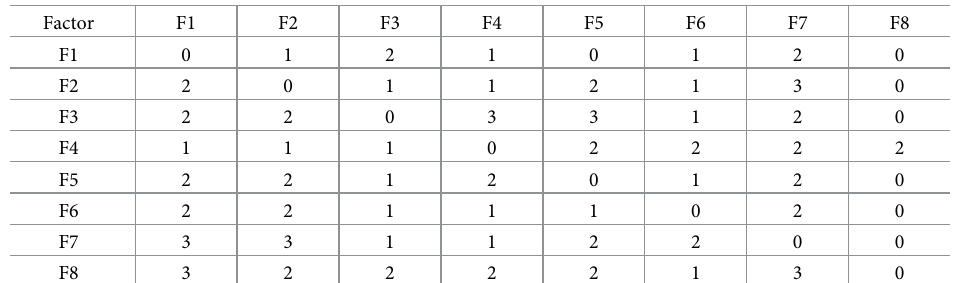
Table 2. Direct-influence matrix A.